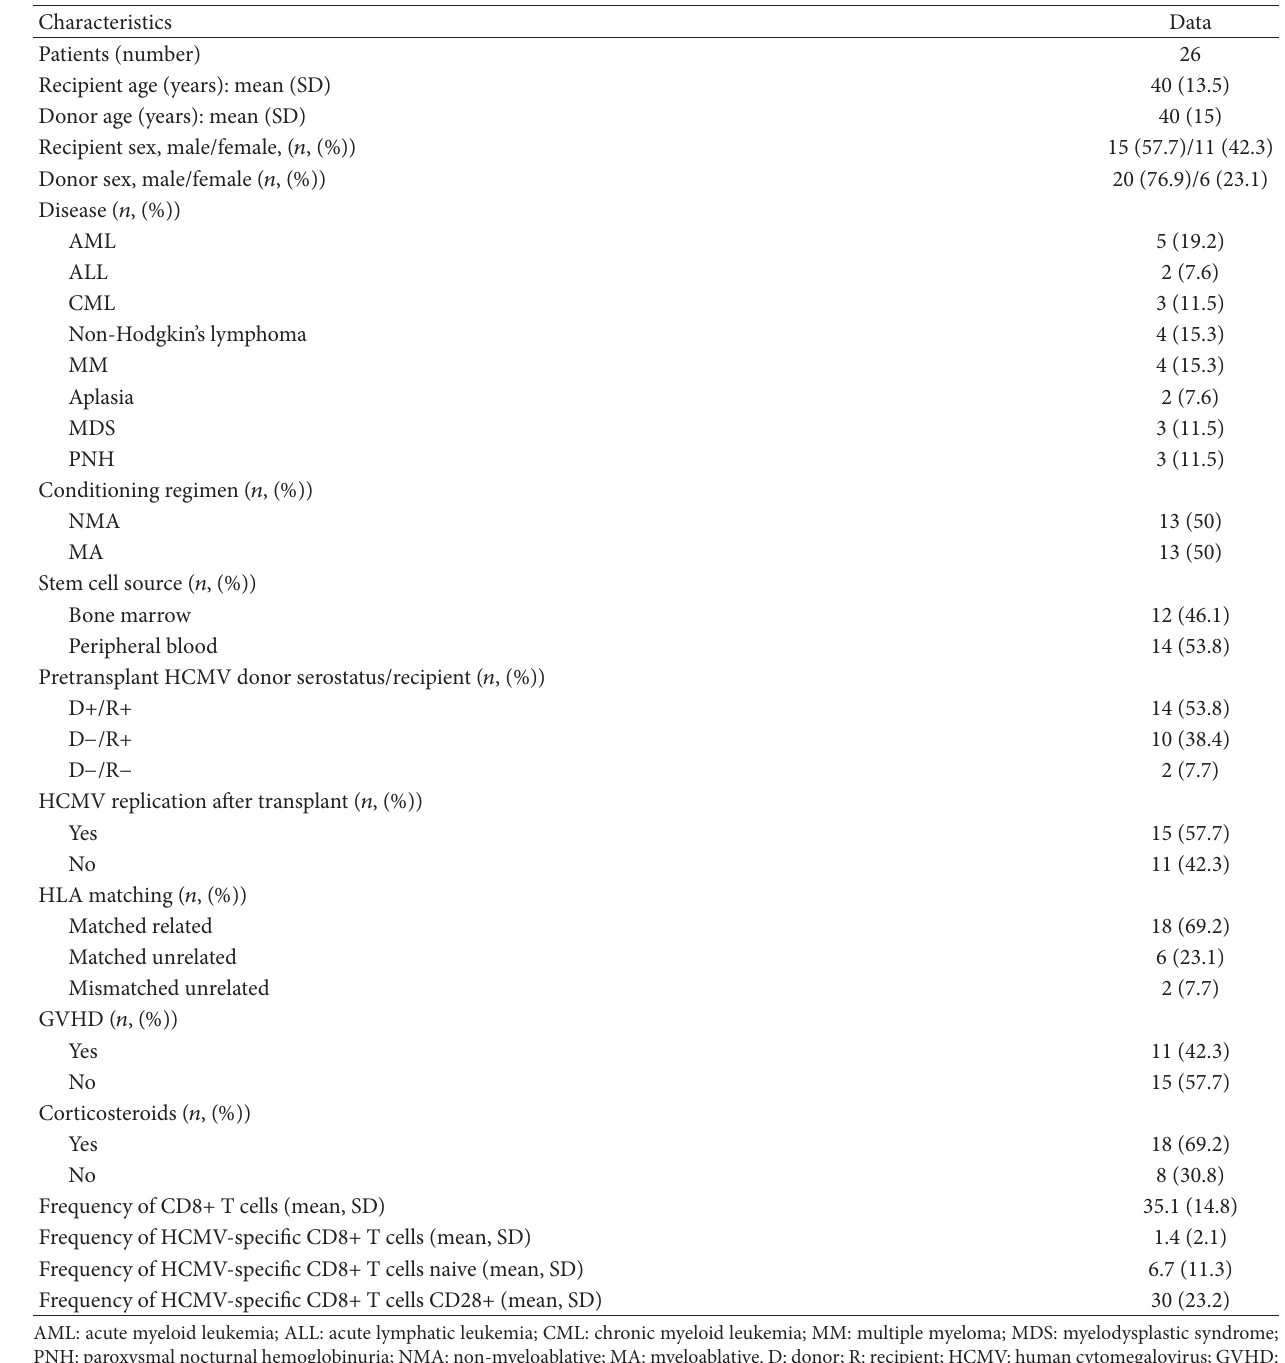
T 1: Clinical characteristics of the study